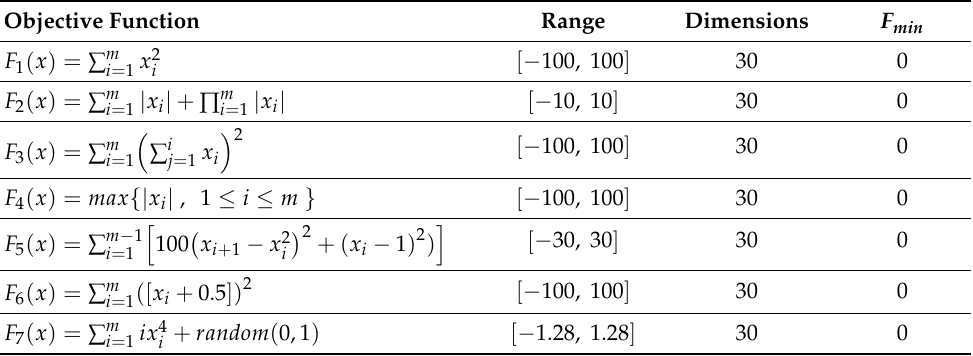
Table A1. Information of unimodal functions.